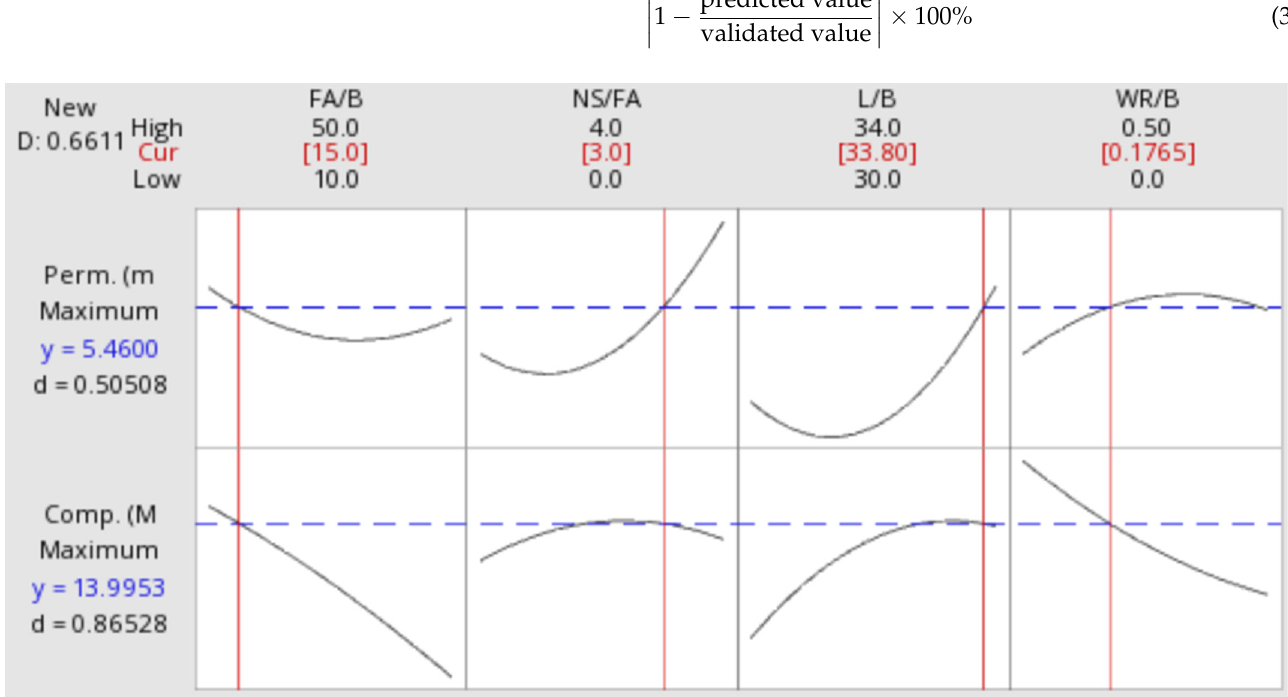
Figure 1. An optimum mix proportion of SMPC for maximum-possible permeability and compressive strength. Table 6. Test results of the compressive strength and permeability for SMPC.